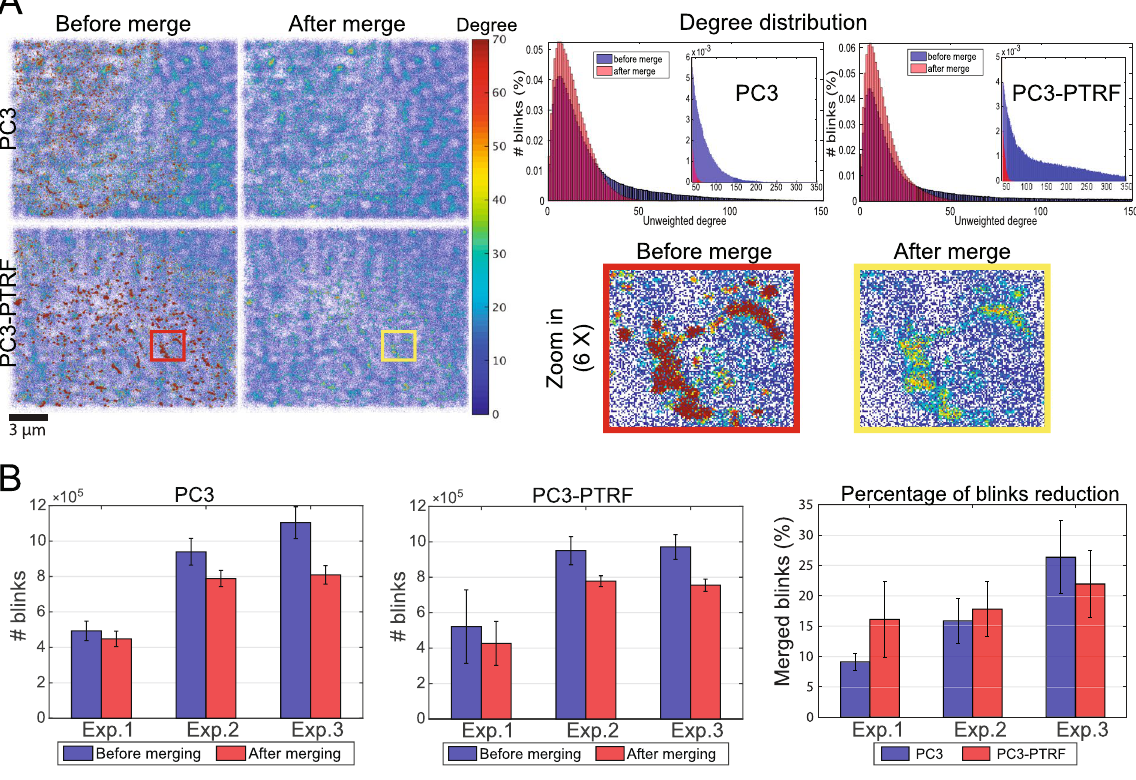
Figure 2. Iterative blink merging to correct multiple blinking of single fluorophores. ( A ) We utilized an iterative merging approach of blinks within T = 20 nm as a preprocessing step to correct for multiple blinking of a single fluorophore, blinking from multiple fluorophores on the same antibody, and multiple secondary antibody labeling of the same Cav1 molecule and associated drift. Network degree measure images and histograms of PC3 and PC3-PTRF cells before and after applying the merge module at 20 nm. ( B ) The number of blinks and the percent reduction of total blinks for each experiment following iterative merging at 20 nm. The error bars represent the standard